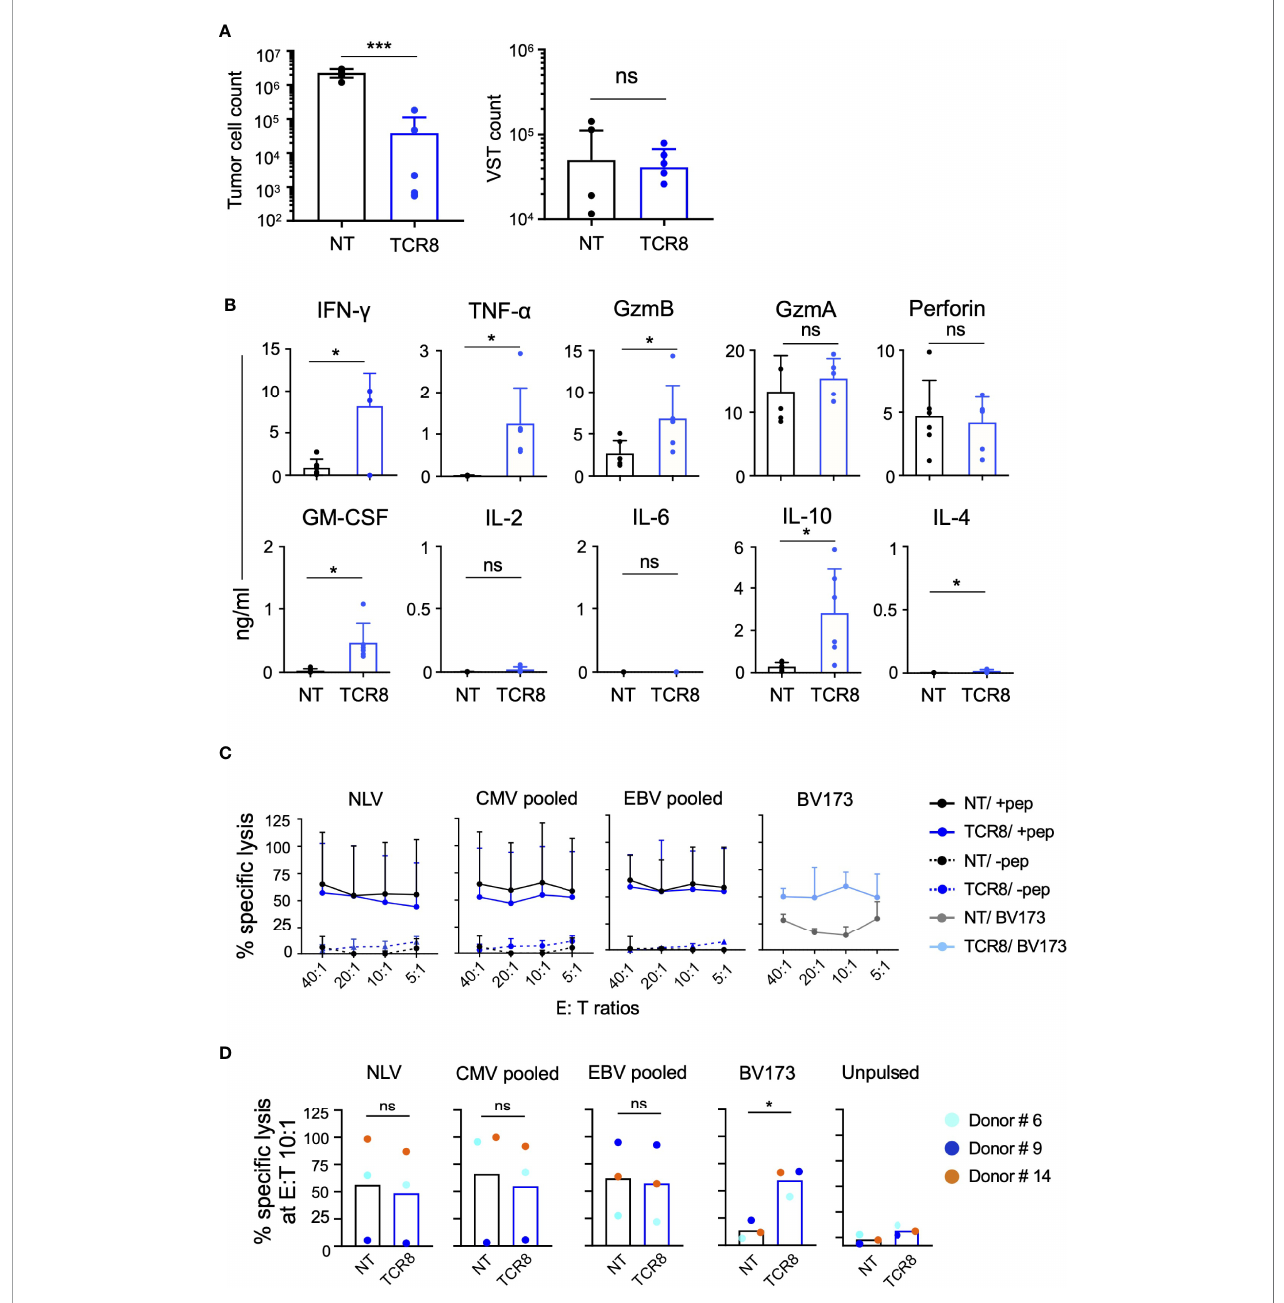
FIGURE 4 | TCR8+ VSTs are cytotoxic in vitro against the cognate viral and tumor targets. (A) Co-culture of NT or TCR8+ VSTs with BV173 leukemia cells (HLA- A2*02:01+survivin+); E:T ratio 1:5. Residual BV173 cells (left) or VSTs (right) quanti fi ed by FACS on day 3, NT vs TCR8+, mean ± SD, Tumor cells: ***p=0.0004; VSTs: p=ns; n=6. (B) Cytokine quanti fi cation in supernatants after 24 hours of coculture, NT vs TCR8+, mean ± SD, IFN- g , TNF- a , Granzyme (Gzm) B, GM-CSF, IL- 10 and IL-4: *p<0.05, n=6. (C) Percent speci fi c lysis of peptide/pepmix pulsed or unpulsed activated autologous T cells or BV173 cells by NT or TCR8+ VSTs in a 4- hour 51 Cr-release assay at E:T ratios of 40:1, 20:1, 10:1, 5:1, mean ± SD, n=4. (D) Summary of percent speci fi c lysis at E:T 10:1 ratio depicting individual donors (colored dots). NT vs TCR8+, mean ± SD, NLV peptide, CMV pooled, EBV pooled: p=ns; BV173 cells: *p=0.01, n=3, paired t-test. ns, not signi fi was almost exclusively directed against EBV and not against A*02:01+survivin+ BV173 leukemia cells were only killed by CMV, while the other two evaluated donors showed TCR8+ but not NT VSTs. Donor heterogeneity with regards to simultaneous responses against both viruses. The anti-leukemic CMV and/or EBV reactivity was high, as illustrated in Figure 4D . For example, anti-viral speci fi city from donor #9 activity conferred by the transgenic TCR was much more